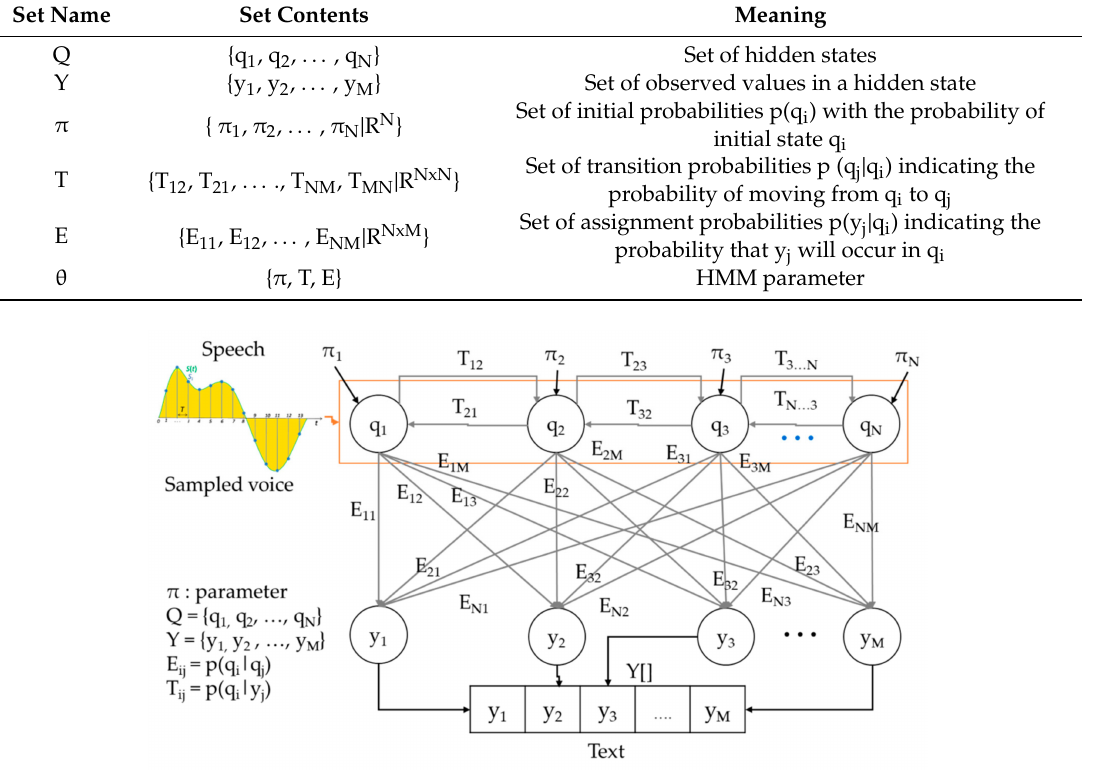
Figure 5. Flowchart of HMM.